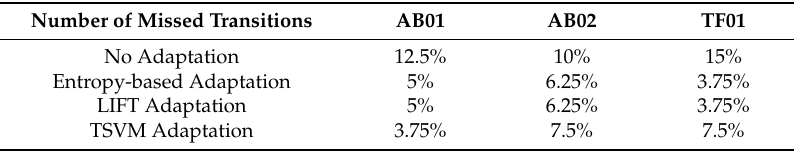
Table 2. The percentage of missed transitions for each subject.